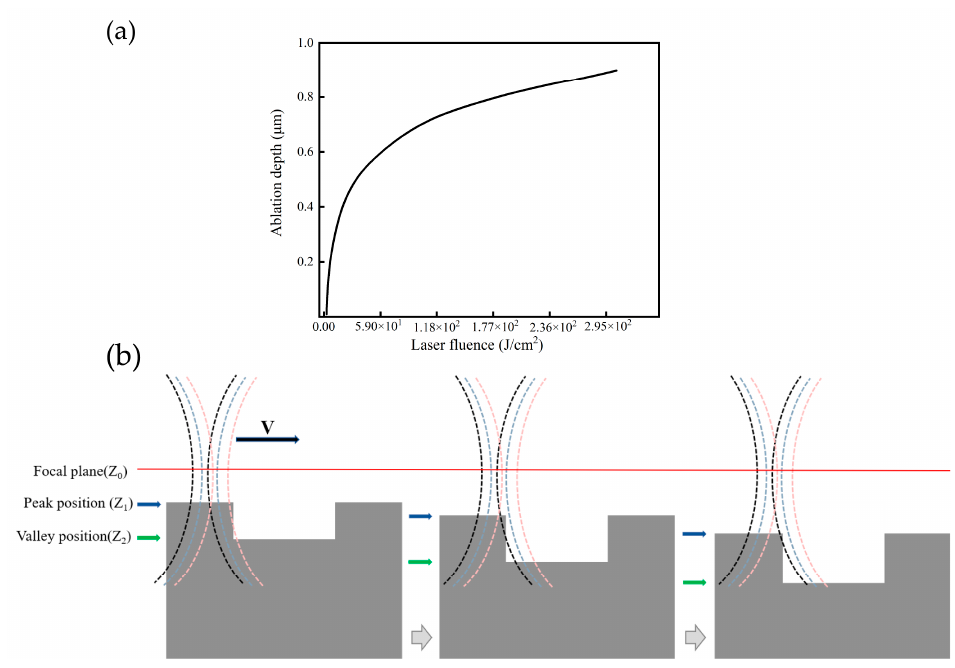
Figure 3. ( a ) Ablation depth variation with laser fluence by TTM; ( b ) Spatial position between micro-structure and laser pulse. Appl. Sci. 2022 , 12 , x FOR PEER REVIEW